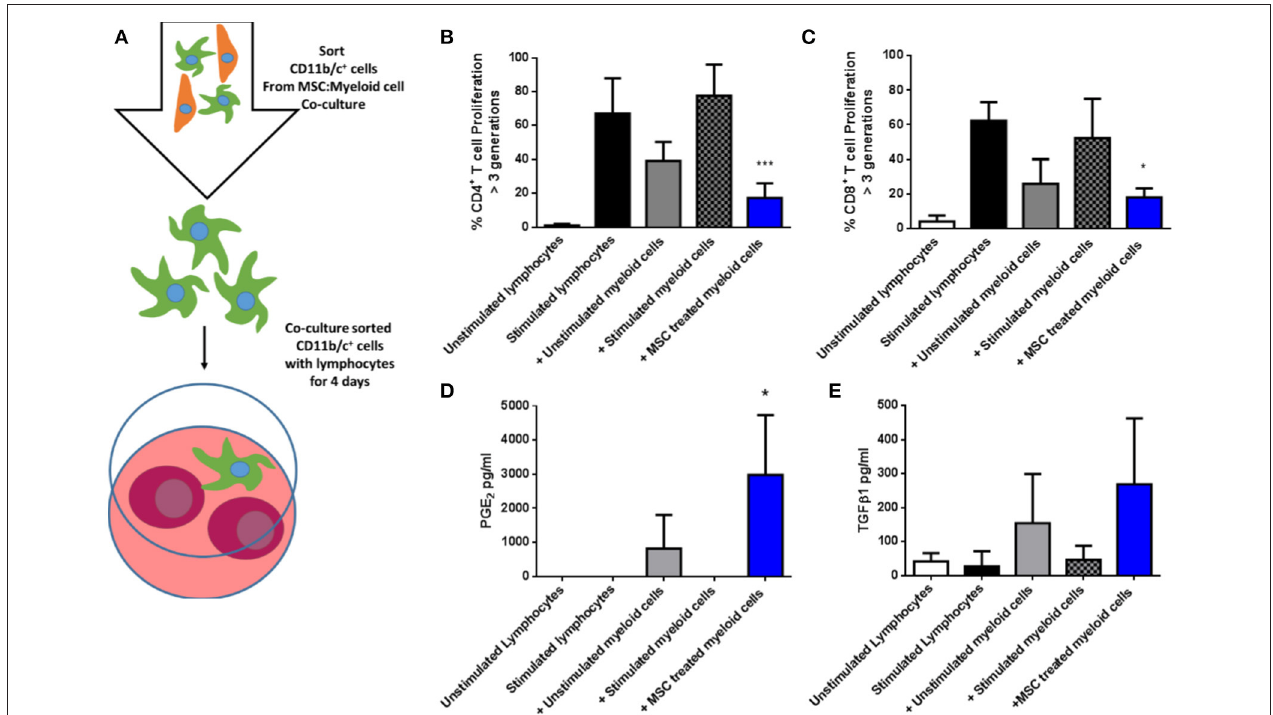
FIGURE 6 | Allogeneic MSC-educated lung myeloid cells more potently suppress T-cell proliferation. (A) Schematic representation of the addition of Lewis rat lung CD11b/c + (myeloid) cells re-sorted from co-cultures with Wistar Furth MSC or control conditions and then added to syngeneic lymphocytes, with, or without anti-CD3/anti-CD28 stimulation for 4 days. (B,C) Graphs of CD4 + (B) and CD8 + (C) T-cell proliferation, quantified by flow cytometry-based fluorescent dye dilution as the proportion of cells that had proliferated through > 3 generations, in 4-day cultures of Lewis rat splenocytes under five conditions: No stimulation (Unstimulated lymphocytes); Anti-CD3/CD28 stimulation alone (Stimulated lymphocytes); Anti-CD3/CD28 stimulation + re-purified unstimulated Lewis rat lung myeloid cells + Unstimulated myeloid cells; Anti-CD3/CD28 stimulation + re-purified, IFN γ /LPS-stimulated Lewis rat lung myeloid cells ( + Stimulated myeloid cells) and Anti-CD3/CD28 stimulation + re-purified Wistar Furth MSC co-cultured Lewis rat lung myeloid cells ( + MSC treated myeloid cells). (D,E) Graphs of the concentrations of PGE 2 (D) and TGF β 1 (E) in 4-day Lewis rat splenocyte cultures under the same five conditions. All data are presented as mean ± SEM with n = 3 in each condition. Statistical analysis was performed using one way ANOVA with Tukey’s post-test, * p < 0.05, *** p <